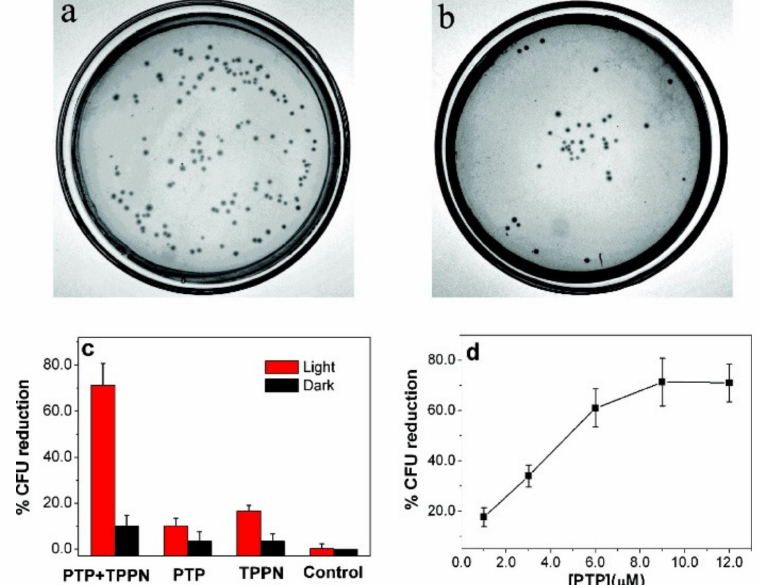
Figure 8. ( a ) Number of colony forming units (cfus) of Escherichia coli ( E. coli ) for control without photosensitizer in dark; ( b ) Cfu of E. coli suspension incubated with PTP/TPPN and irradiated with white light; ( c ) biocidal activities of PTP/TPPN, PTP, and TPPN toward E. coli in the dark and under white-light illumination for 5 min. ( d ) Reduction in cell viability of PTP/TPPN complex toward E. coli as a function of PTP concentration. Reprinted with permission from [76]. Copyright (2009) American Chemical